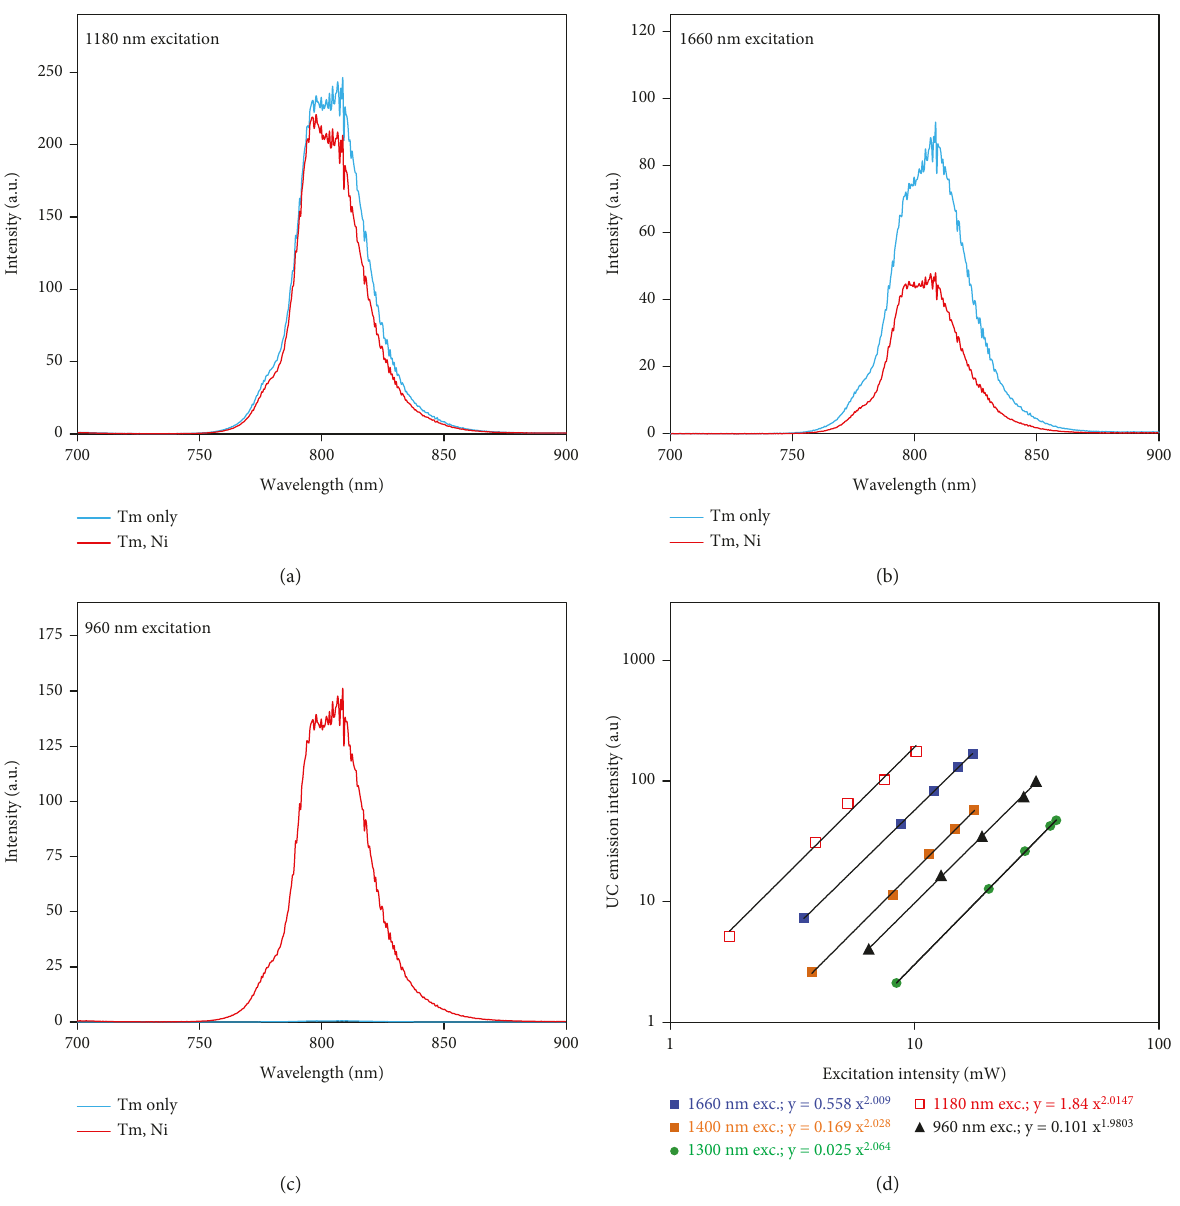
Figure 2: UC emission spectra of the Tm-only doped and Tm and Ni codoped CaTi absorption), (b) 1660nm (Tm 3+ -only absorption), and (c) 960 nm (Ni 2+ -only absorption). (d) Excitation power-dependent UC emission intensities for the Tm and Ni codoped sample while excited at various